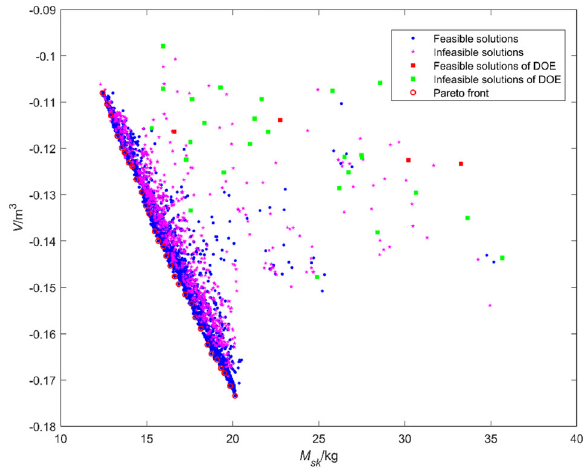
Fig. 19 Solutions obtained by EGDCMO on structure